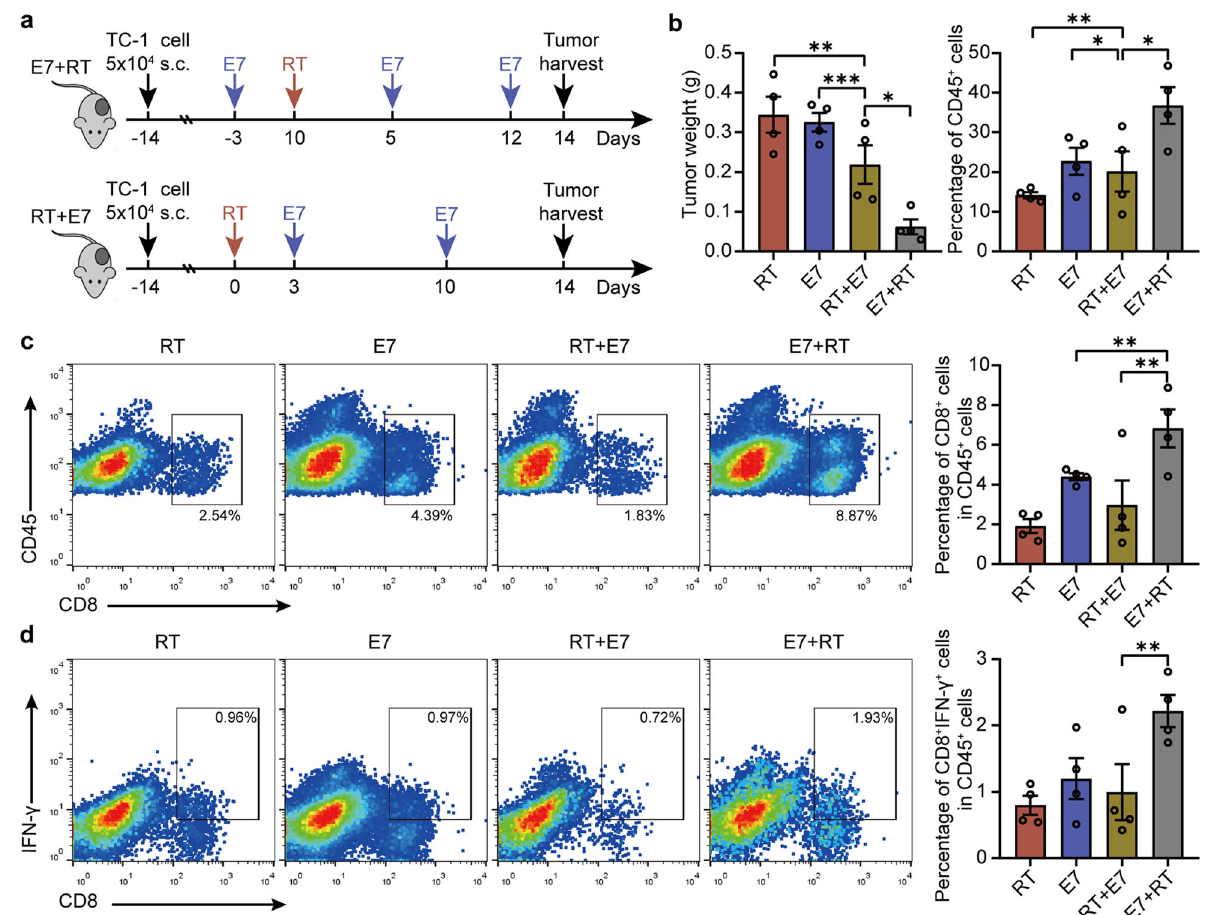
Fig. 3 Therapeutic cancer vaccine followed by radiation induced more leukocytes and CD8 + effector T cell in fi ltration in the tumors. Established TC-1 tumors were treated by radiation alone or by the combinations of radiation with vaccines before or after radiation. The tumors were harvested on 14 days after RT. a Experimental procedures. b The tumor weights (left) and the percentage of CD45 + cells (right) in the tumors determined by FACS. c The percentage of CD8 + cells in CD45 + cells in the tumors, and d the percentage of CD8 + IFN- γ + cells in CD45 + cells in the tumors analyzed by fl ow cytometry. Experiments were repeated three times and two-tailed t -test was used for comparisons of biological replicates. Data are presented as mean ± SD; n = 4 mice/group. * P < 0.05, ** P < 0.01, *** P <